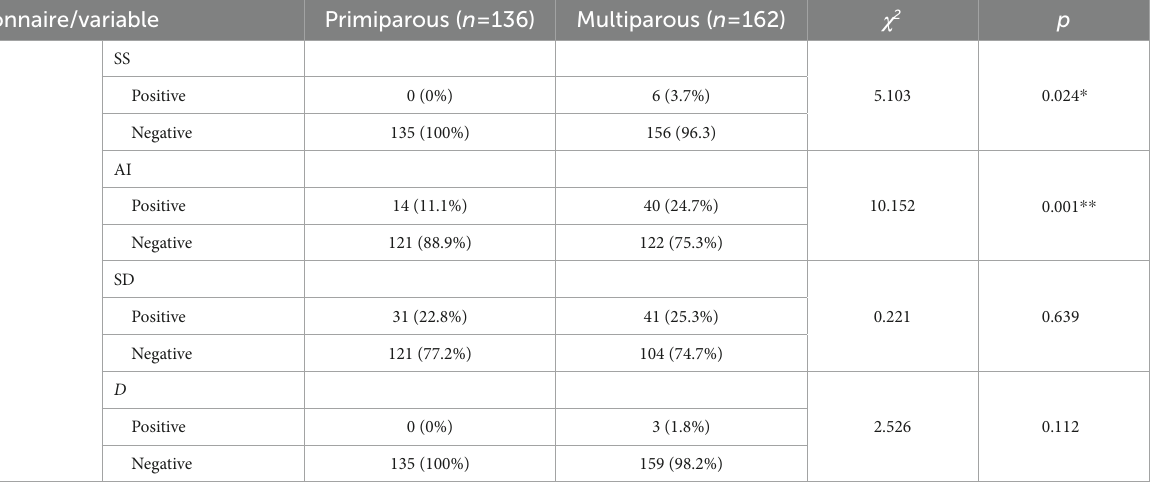
TABLE 4 Prevalence of General Health